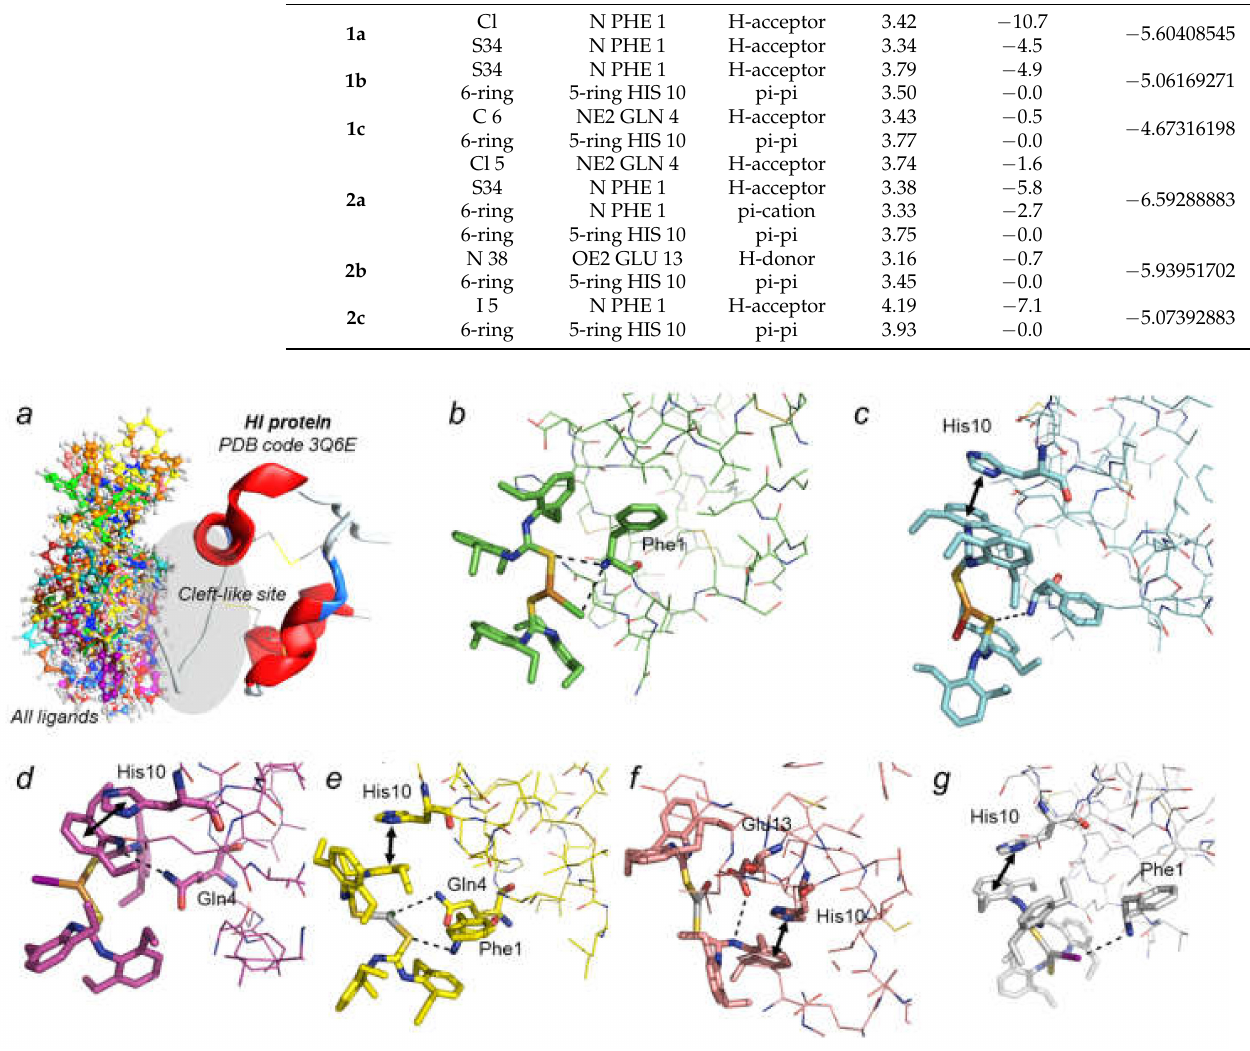
Figure 9. Analysis of the binding pattern of all the metal-based ligands complexes inside the active cleft of human insulin. ( a ) represents all the superposed docked metal-based ligands com- plexes; ( b – g ) represent the interaction profile for metal-based ligand complexes: ( b ) for 1a , ( c ) for 1b , ( d ) for 1c , ( e ) for 2a , ( f ) for 2b , and ( g ) for 2c . The molecule and interactive residues are shown as sticks, while the rest of the active site residues are shown in wireframe models. Hydrogen bonding interactions are shown as black dotted lines, metered with the distance in Å, and π – π interactions are shown by double-sided